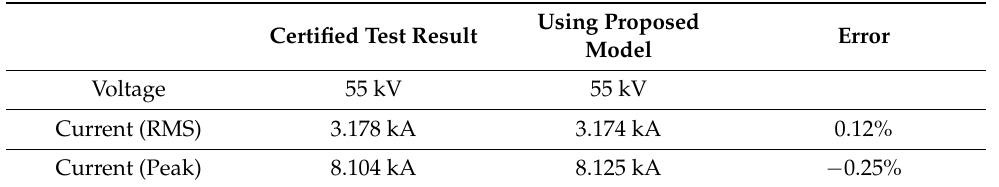
Table 4. M-phase short-circuit test result of Scott transformer (comparison between short-circuit test results obtained by RTDS and those in the certified test report).